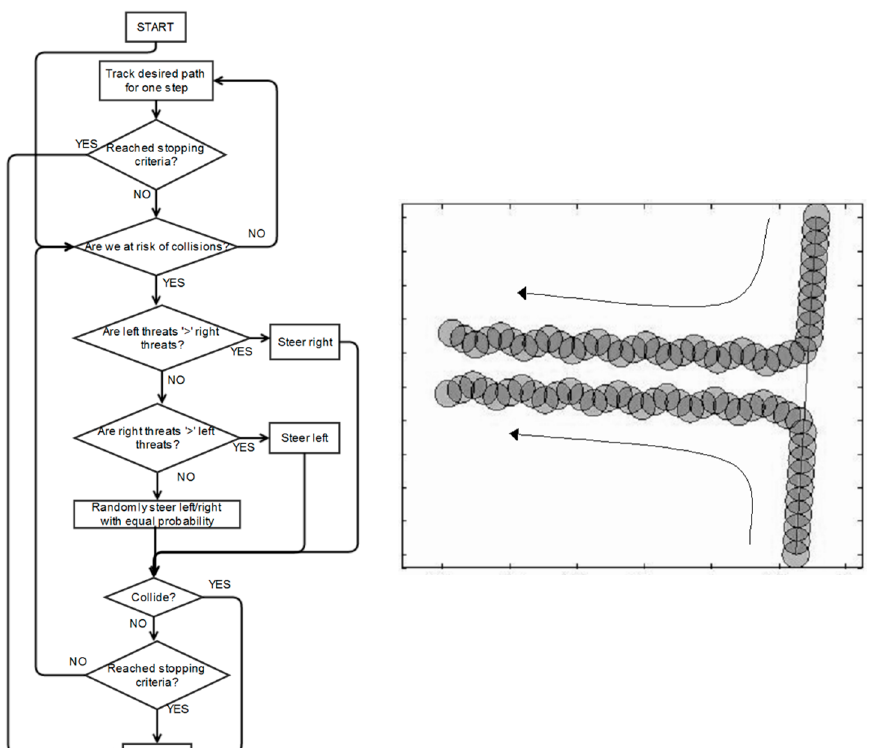
Figure 10. Flow chart of original simple scheme and illustration of pathological synchronized